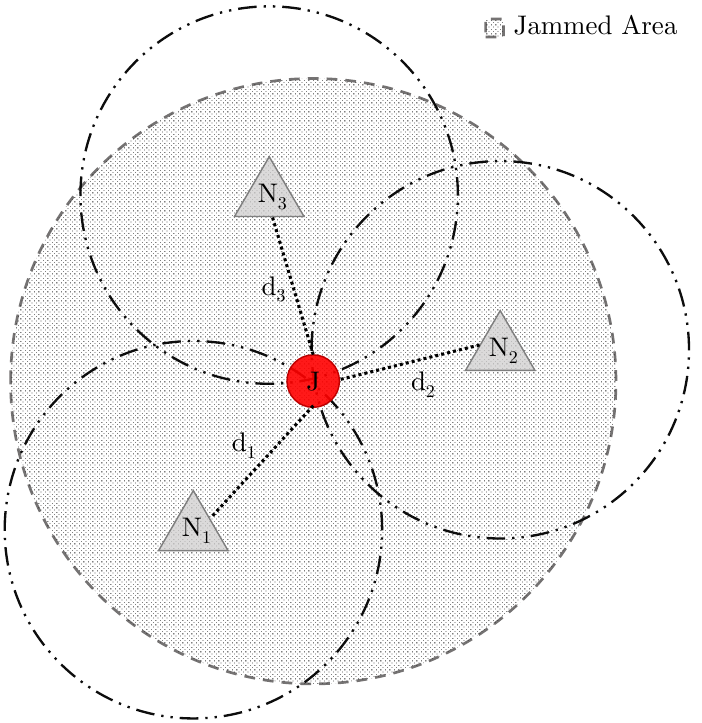
Figure 2. Jammer localization by three-lateration: 3 sensors collaborating to estimate the jammer